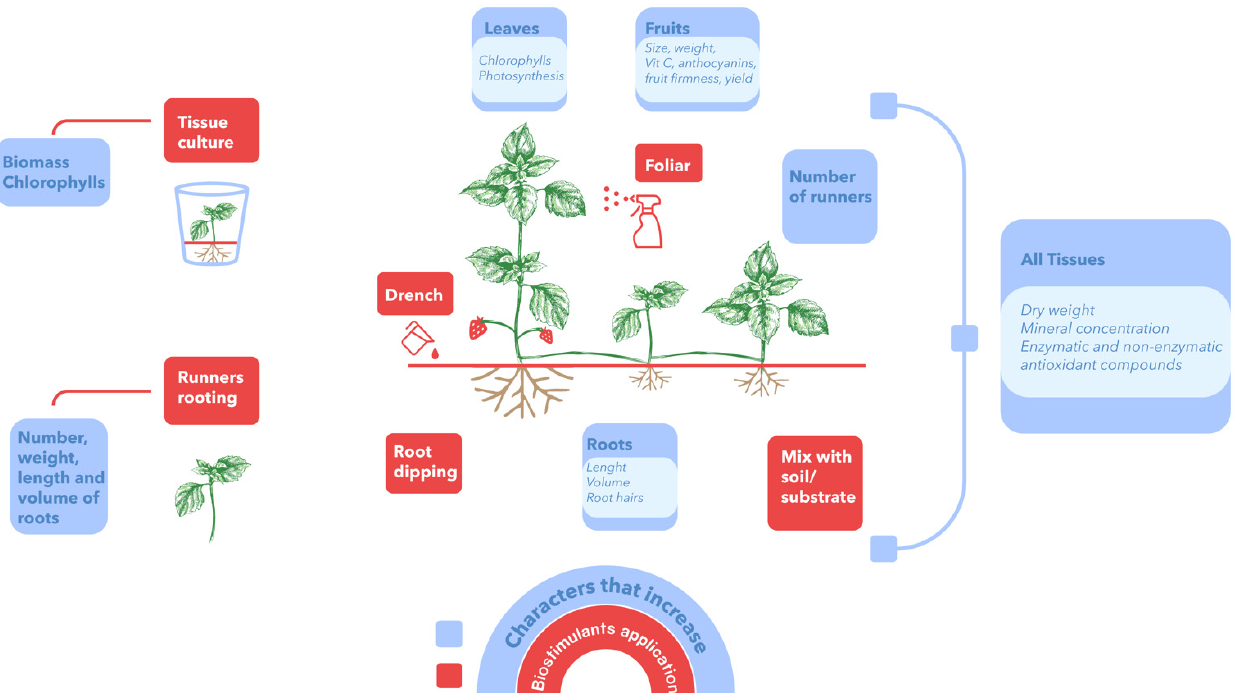
Figure 3. Forms of application of biostimulants and main effects on strawberry plants. Figure prepared by the authors with information reported in the tables of this review.